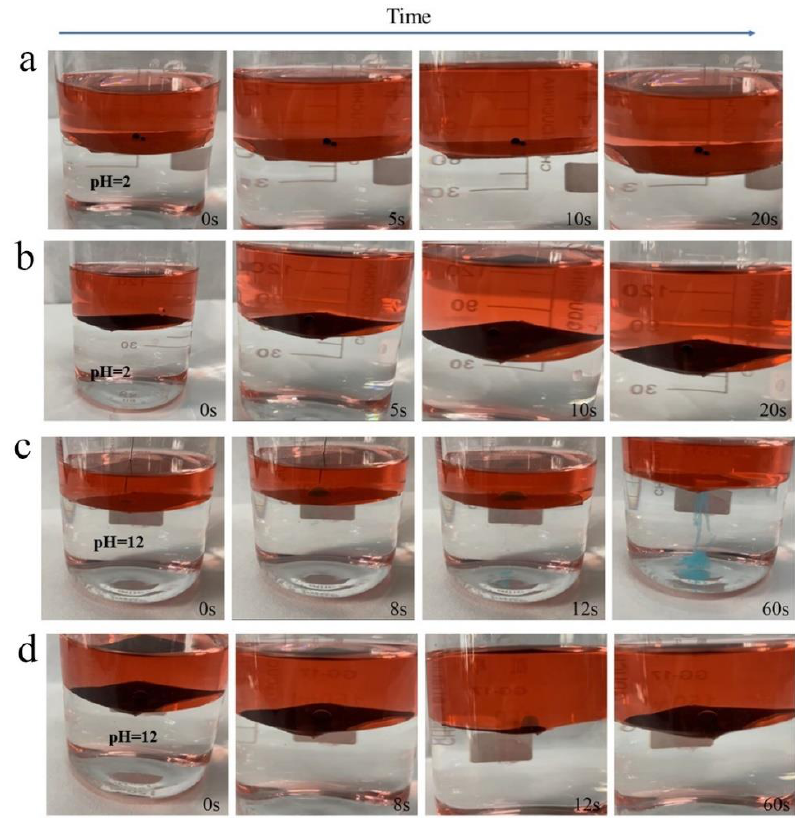
Figure 4. Directional penetration of water droplets across the resulting “JM” in oil–water systems. ( a , b ) Positively and reversely aligned “JM” floating on the water solution (pH = 2) with a water droplet seated on the integrated membrane with both hydrophobic sides. ( c ) Positively aligned “JM” with a water droplet seated on the hydrophobic side creating a larger driving force for penetration due to the superhydrophilic bottom layer. ( d ) Reversely aligned “JM” with a water droplet seated on the smart side was subject to spreading without